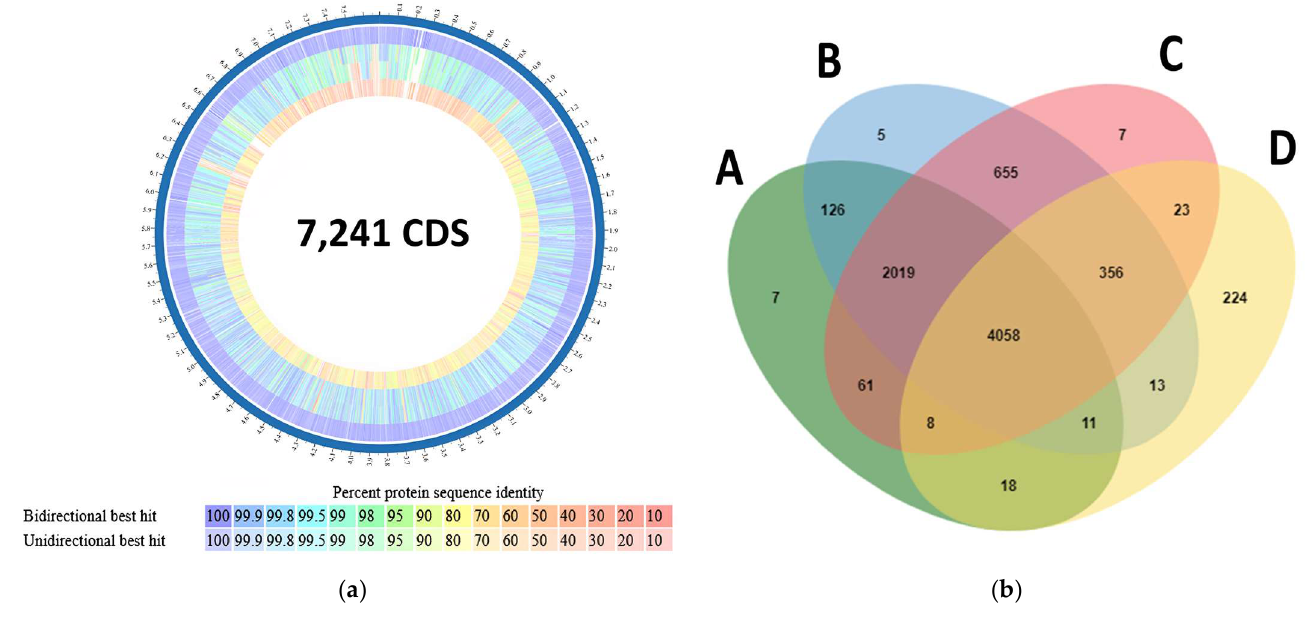
Figure 7. ( a ) Proteome similarity analysis carried out by the proteome comparison tool on PATRIC between—as ordered from the outside to the inside— S. vinaceusdrappus strain AC-40 as a reference, S. vinaceusdrappus strain JCM 4529, S. plicatus strain JCM 4504, and S. rochei strain 7434AN4; ( b ) A Venn diagram indicated the shared orthologous protein clusters among A ( S. vinaceusdrappus strain AC-40), B ( S. vinaceusdrappus strain JCM 4529), C ( S. plicatus strain JCM 4504), and D ( S. rochei strain 7434AN4).